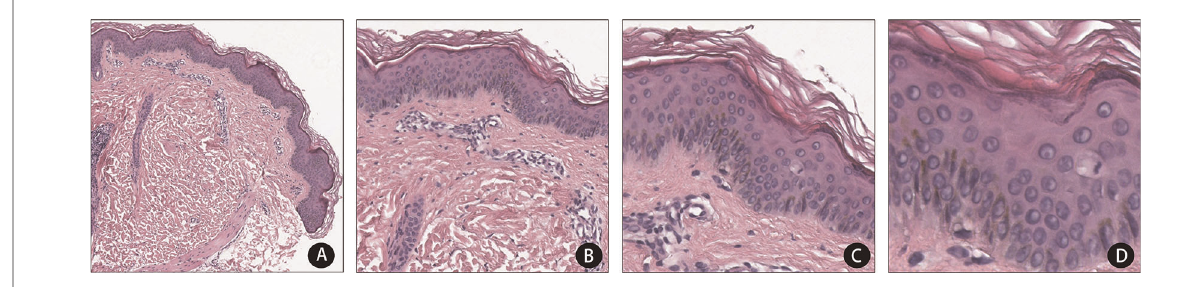
FIGURE 2 H&E stain revealed the reticular epidermis is hyperkeratosis and perivascular lymphocytes and a few neutrophils in fi ltrating in the dermis. (hematoxylin and eosin, original magni fi cation A ×40, B ×100, C ×200, D